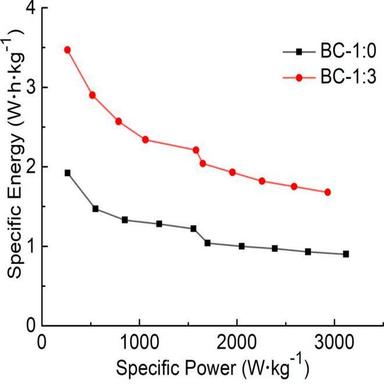
Ragone plot of the symmetric supercapacitor fabricated using intrinsic and nitrogen doped DDGS biocarbon.